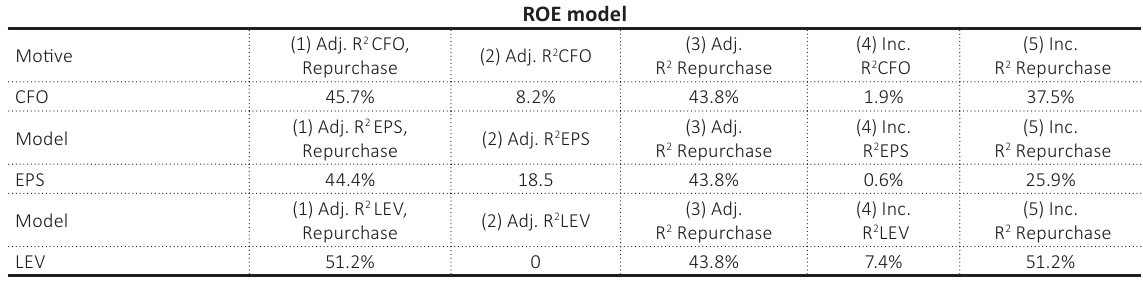
Table 10. Incremental explanatory ability for share repurchases motives on financial